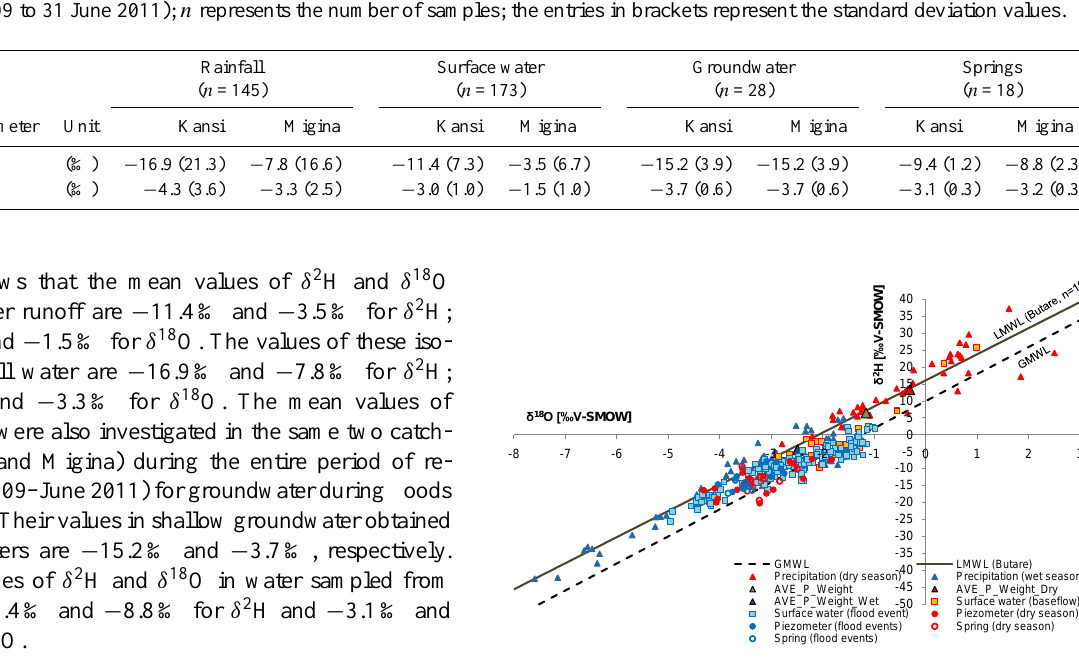
Figure 6 Stable isotope compositions of rainfall, surface water, springs, shallow groundwater, and amount weighted rainfall for dry and wet seasons. GMWL: δ 2 H = 8.13 δ 18 O + 10.8 (Source: Clark and Fritz, 1997). GMWL is the Global Meteoric Water Line; LMWL is the Local Meteoric Water Line for Butare; AVE_P_Weight means the average weight rainfall concentration for water sampled during wet and dry seasons; AVE_P_Weight_Dry means the average weight rainfall concentration for water sampled in summer season; and AVE_P_Weight_Wet represents the average weight rainfall concentration for water sampled during in rainy season.